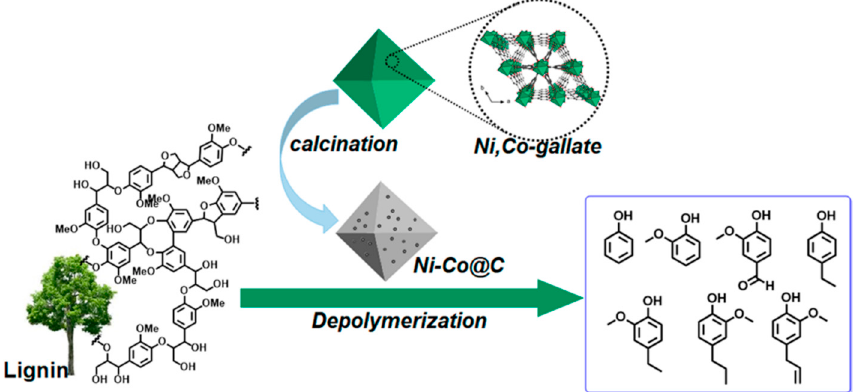
Figure 10. MOFs derived carbon catalysts for lignin conversion. Reprinted with permission from Ref. [212] . Copyright 2019, American Chemical Society.